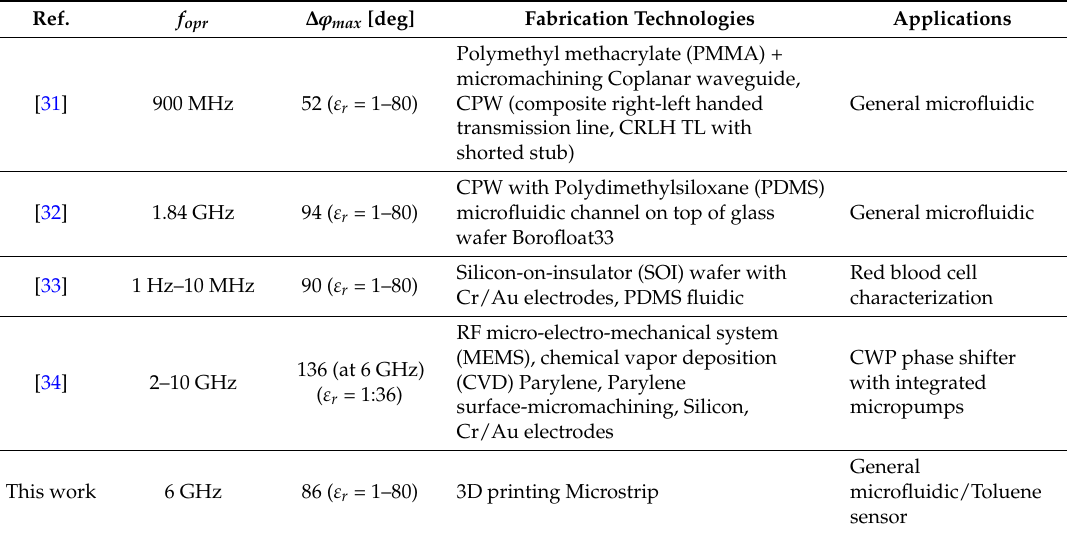
Table 3. Comparison of the characteristics of the proposed sensor and other recently published sensors that operate according to the phase-shift